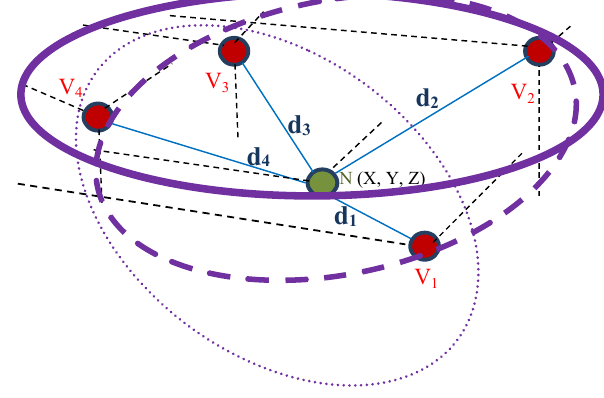
Figure 4. Formation of clusters in case of 5 anchor